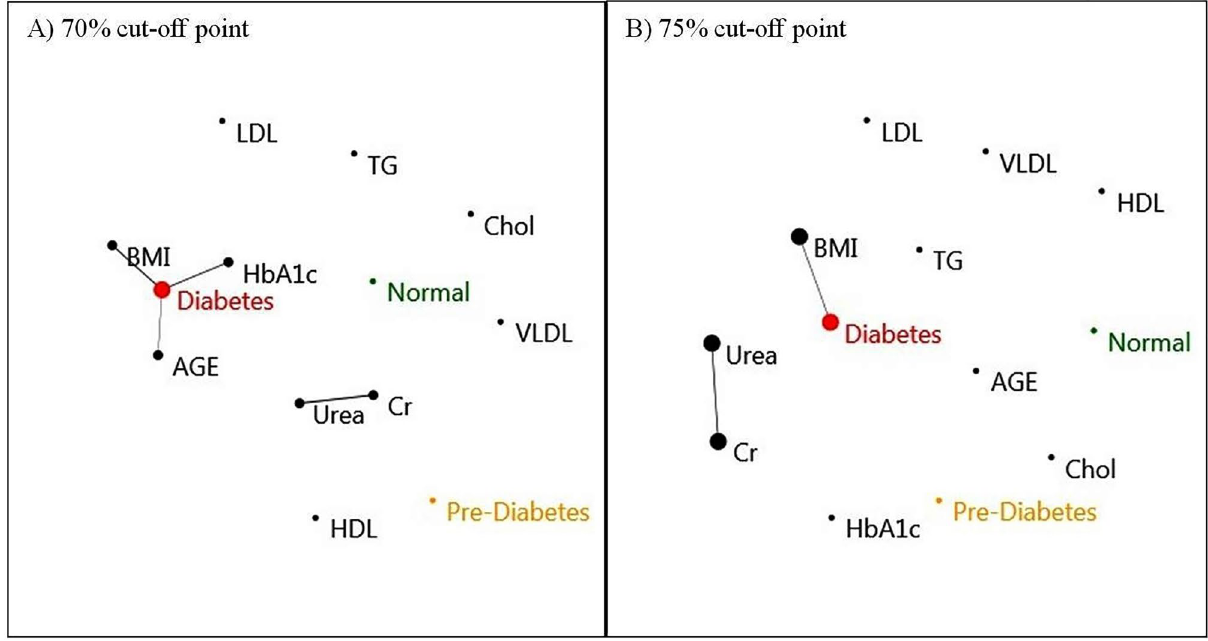
Figure 3. Correlation-based network analysis of blood biochemical markers, age, BMI, and diabetes. All parameters are defined by circles within the network. Network analysis and visualization was carried out using PAST and Fruchterman–Reingold algorithm as a force-directed layout algorithm. The Pearson correlation levels of ( A ) 70%, ( B ) 75% were selected to determine the connections between edges and nodes in terms of incident diabetes. The 70% and 75% cut-off points were the maximum level at which biochemical markers and all parameters demonstrated no relation with diabetes, respectively. Nodes represent parameters related to incident diabetes. Edges indicate the interactions between all factors. The node and edge sizes are proportional to the clustering and correlation coefficients, respectively. Small nodes and thin edges refer to small values. Normal non-diabetes, Cr creatinine, Chol cholesterol, TG triglyceride, BMI body mass index. Marker AUC SE